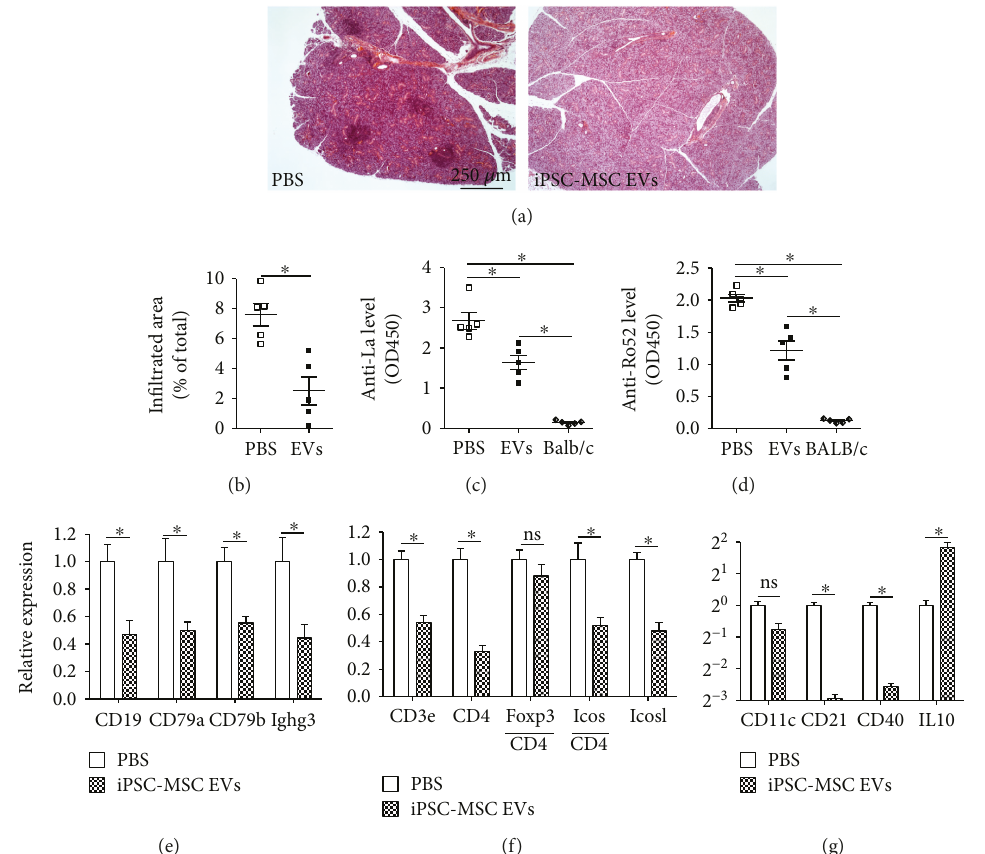
Figure 4: E ff ects of iPSC-MSC EVs on preventing the onset of sialadenitis in NOD mice. (a) H&E staining of SMG sections. (b) Relative area of lymphocytic in fi ltrates in SMGs. (c, d) Serum level of autoantibodies determined by ELISA. Expression of genes related to B cells (e), T cells (f), and APCs (g) in SMGs determined by qRT-PCR. n = 5 ; ∗ P < 0 05 ; ns: not signi fi